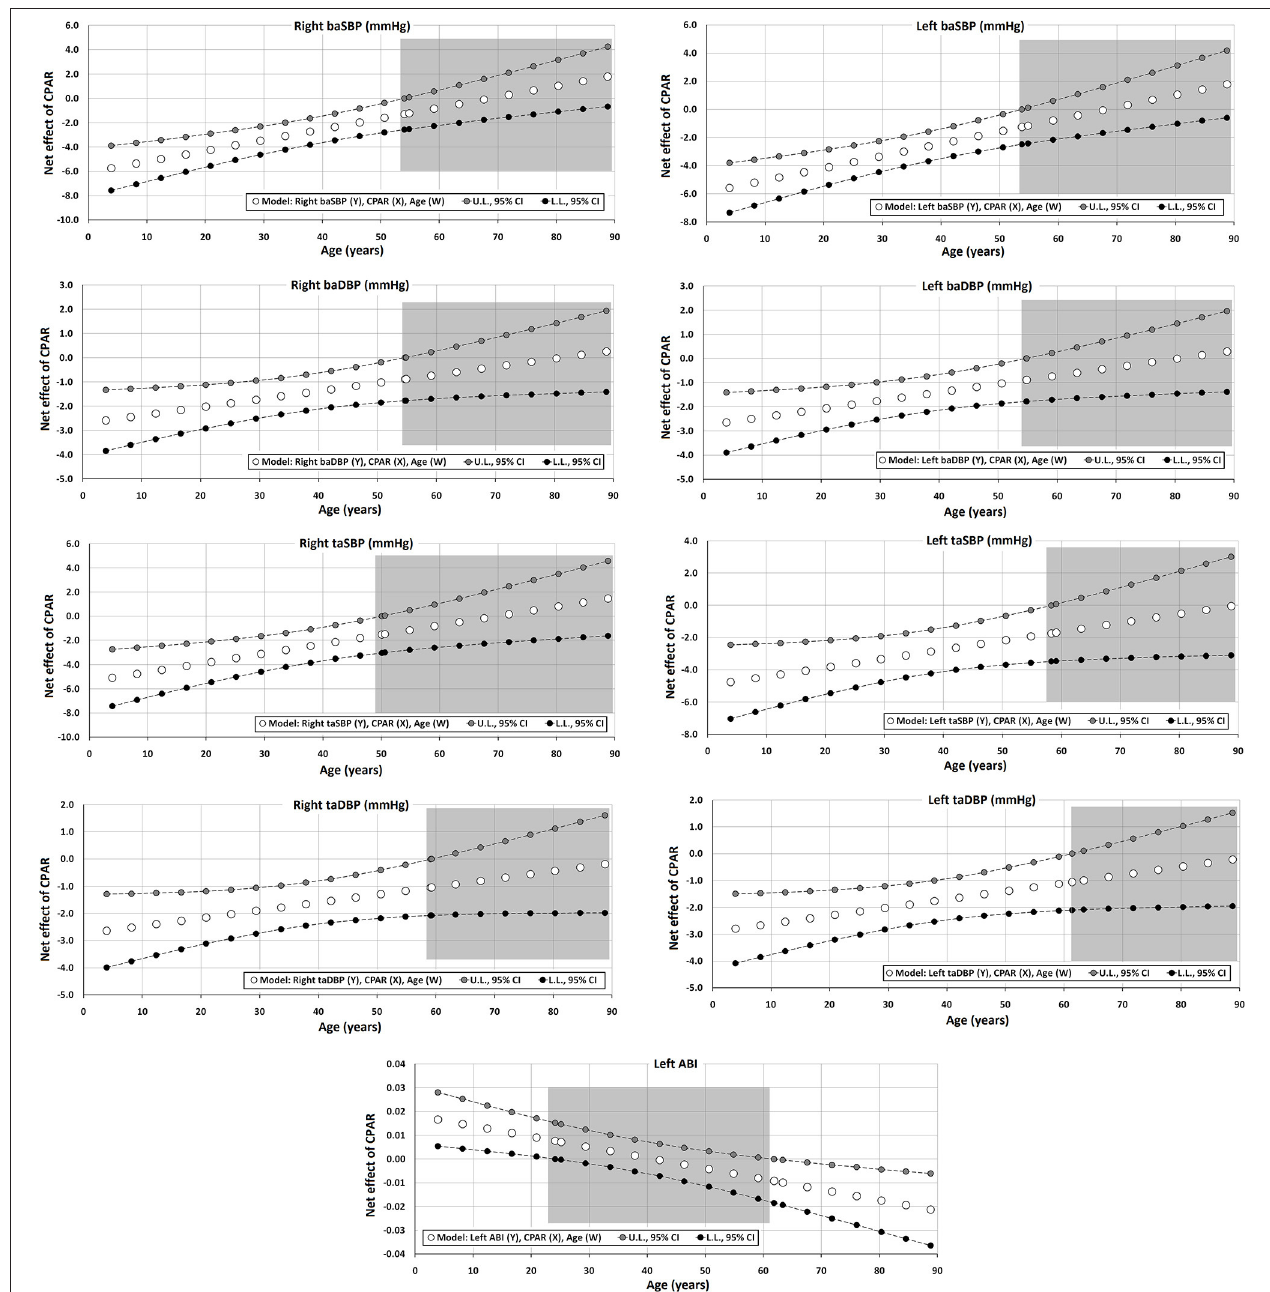
FIGURE 3 | Effect of CPAR condition on brachial and tibial artery blood pressure and brachial-ankle index: effects at different ages throughout life. The gray area shows regions that do not reach statistical significance. Complete quantitative information related to interactions and/or Johnson-Neyman regions is detailed in Supplementary Tables 2 – 95 . In each panel, the “net or absolute conditional effect” (and its 95% confidence interval) of reaching CPARs = 1, quantified in units of the cardiovascular variable, was plotted as a function of age. If the confidence interval crosses the value “0,” the effect of CPARs on the cardiovascular variable becomes statistically non-significant ( p ≥